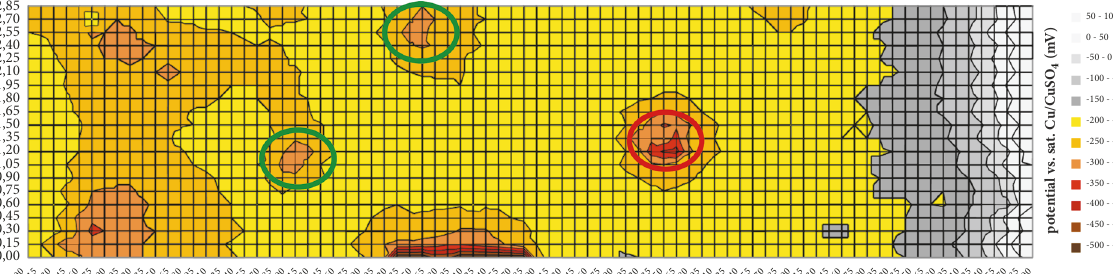
Figure 7: Potential mapping results of the large-scale specimen—four anodes, the galvanized stairway, and the connected floor